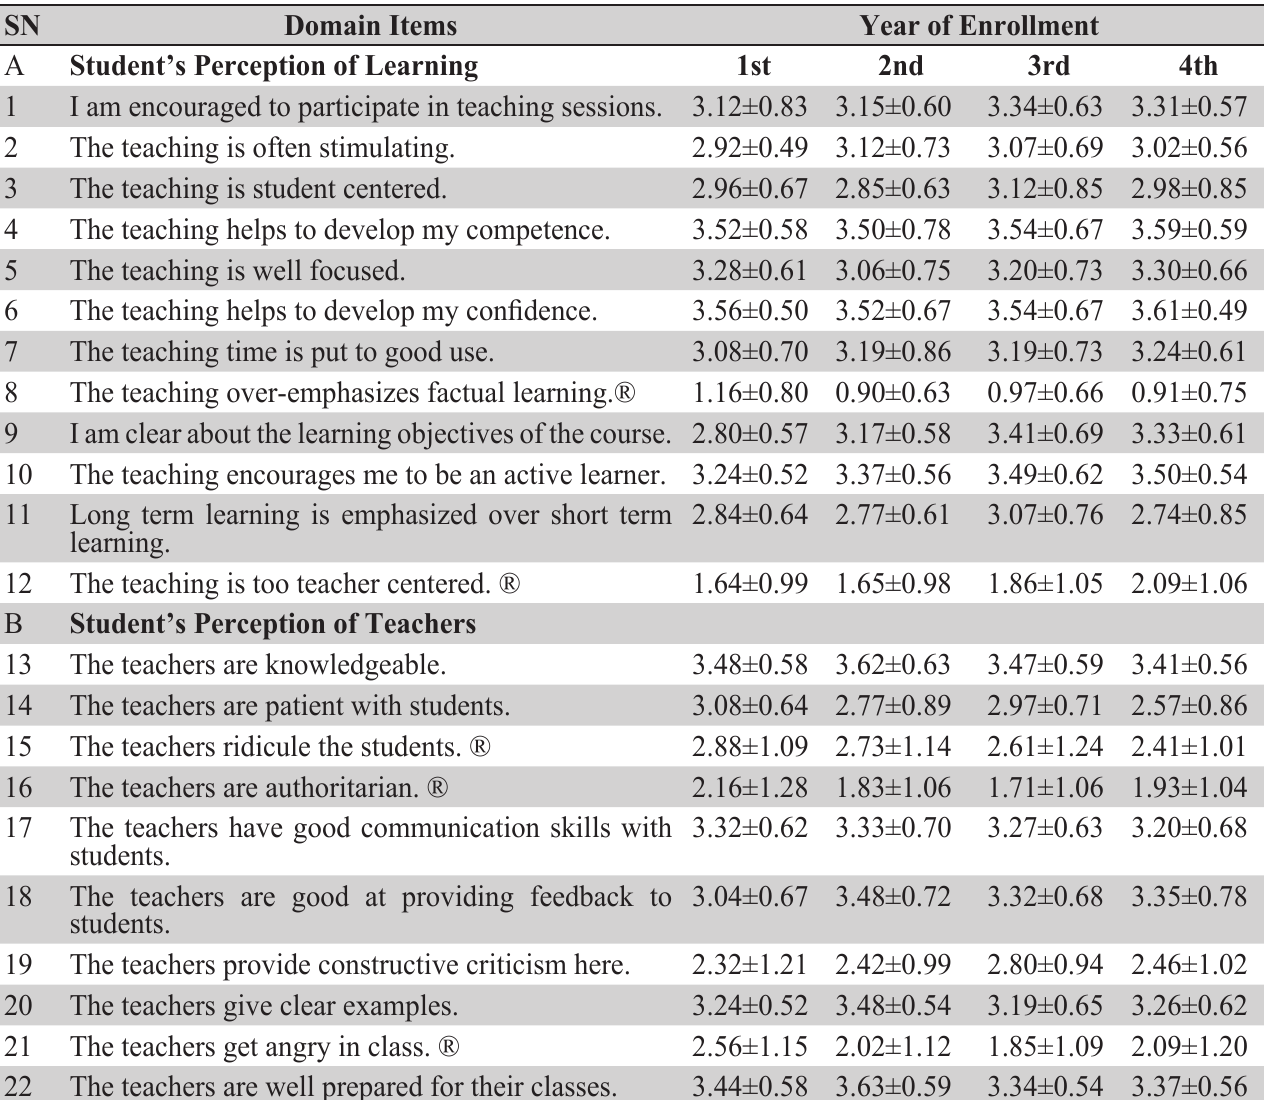
Table 3. Mean scores of Individual items of DREEM(N=190).